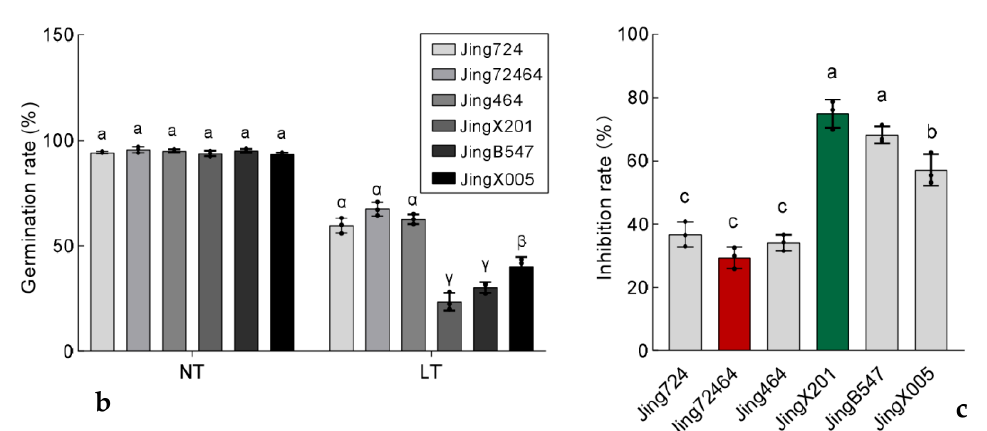
Figure 1. Germination rate of different elite maize inbred accessions under low temperature ( a ) Daily average temperature (green line) from 20 March to 20 June in the field where experiment conducted. The color-filled zone indicated the duration time after sowing when 5 percent coleoptile of Jing72464 emerged from the soil. Blue color zone indicated low temperature (LT) condition that seeds were sowing in early spring, while brown color zone indicated normal temperature (NT) condition that seeds were sowing in summer. ( b ) Germination rate of 6 maize inbred accessions in the filed condition under LT or NT. Data represent mean values of three independent replicate ( n > 1000). ( c ) Inhibition rate of LT on seed germination. Inhibition rate was calculated as the germination rate in LT versus that in NT. Significant differences in ( b , c ) were labeled with different Roman (a, b) or Greek letters ( α , β ).